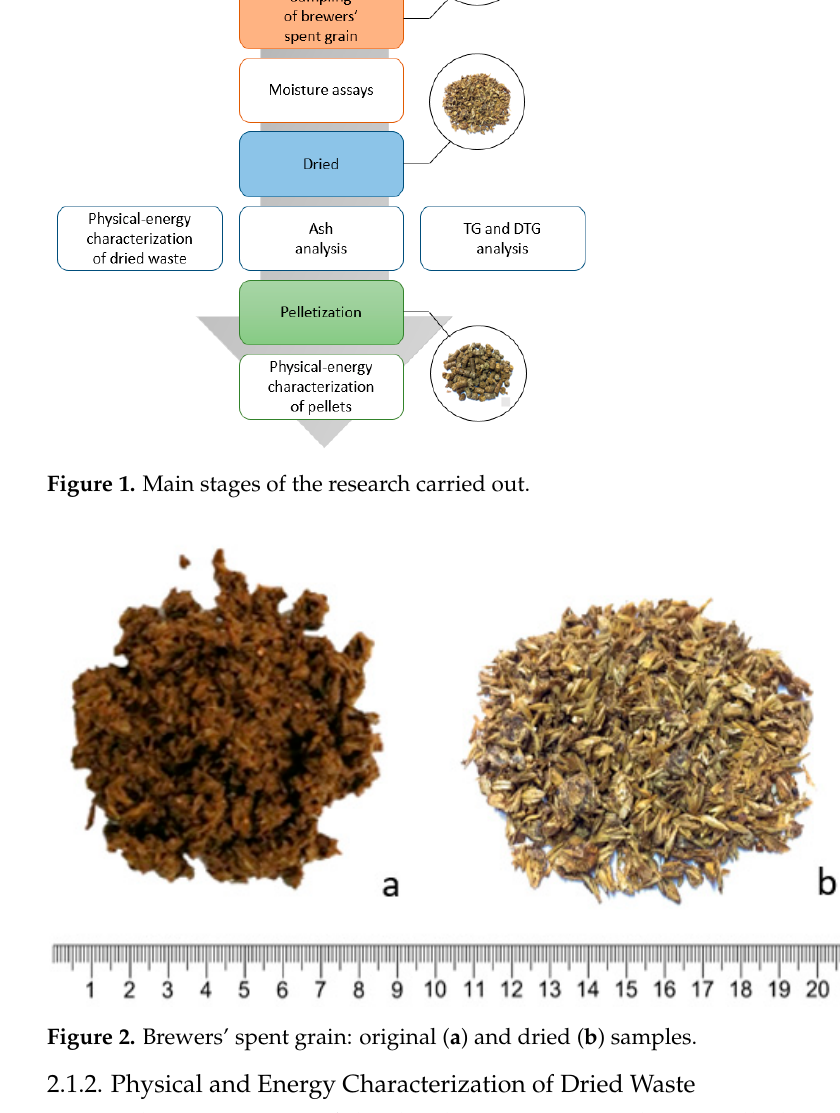
Figure 1. Main stages of the research carried out.